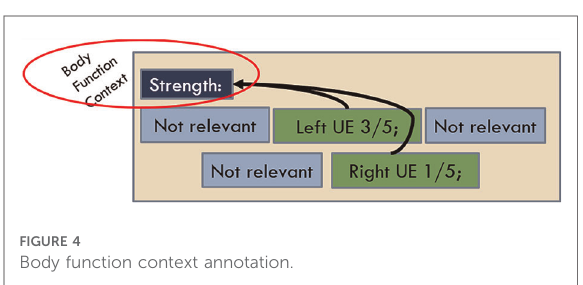
FIGURE 4 Body function context annotation.